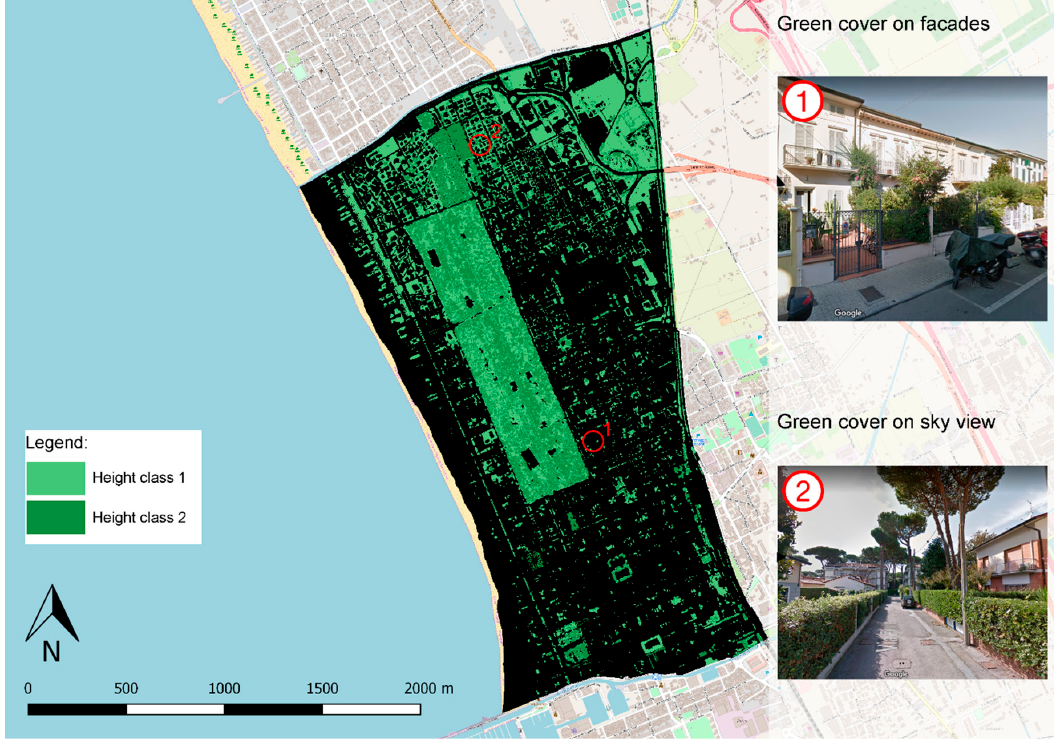
Figure 4. Urban green map classification.